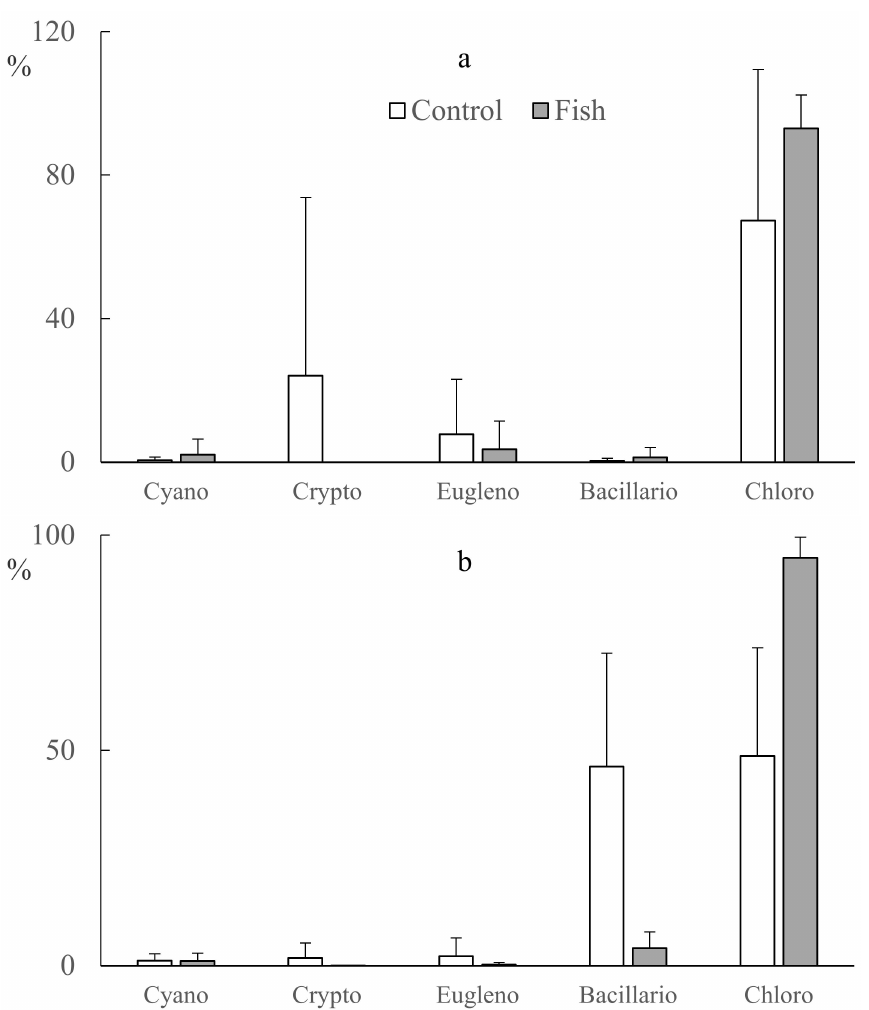
Figure 4. The percentage of total biomass (biovolumes) of different groups of planktonic ( a ) and benthic ( b ) algae in the control and fish treatments at the end of the experiment. Bars indicate ± 1 SD. Cyano—Cyanophyta, Crypto—Cryptophyta, Eugleno—Euglenophyta, Bacillario—Bacillariophyta,